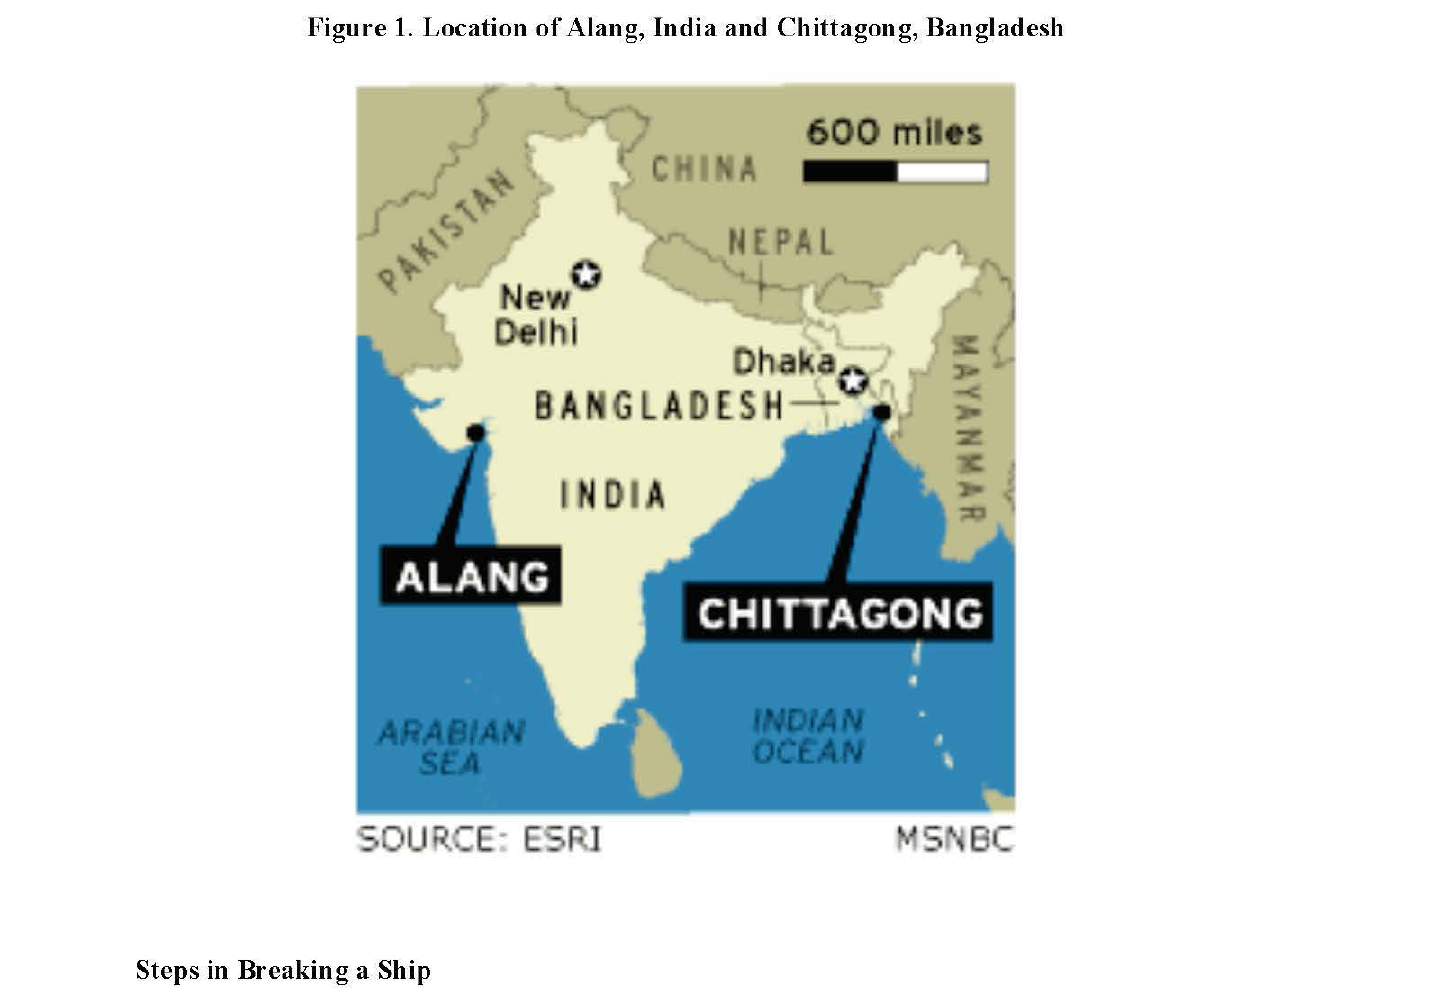
Figure 1 for the geographic location of the two ship breaking capitals). Leadership in ship breaking has alternated between India and Bangladesh over the last ten years (World Bank 2010: 14). Figure 1. Location of Alang, India and Chittagong,